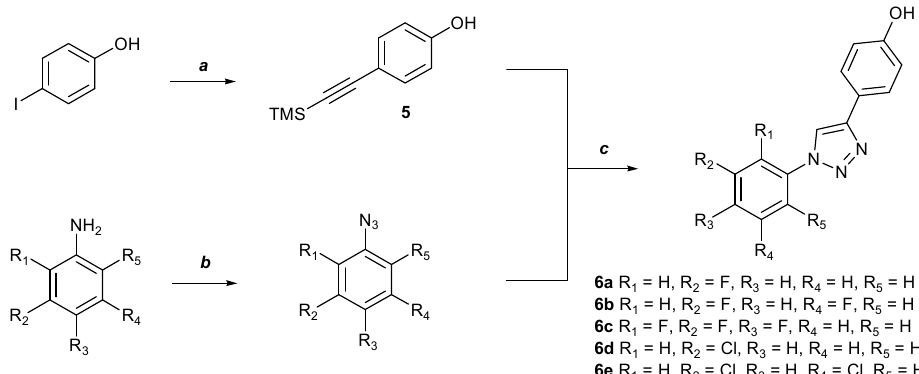
Scheme 1. Synthesis of 4-(1-phenyl-1 H -1,2,3-triazol-4-yl)phenol derivatives 6a – e : ( a ) ethynyltrimethylsilane, PdCl 2 , Ph 3 P,